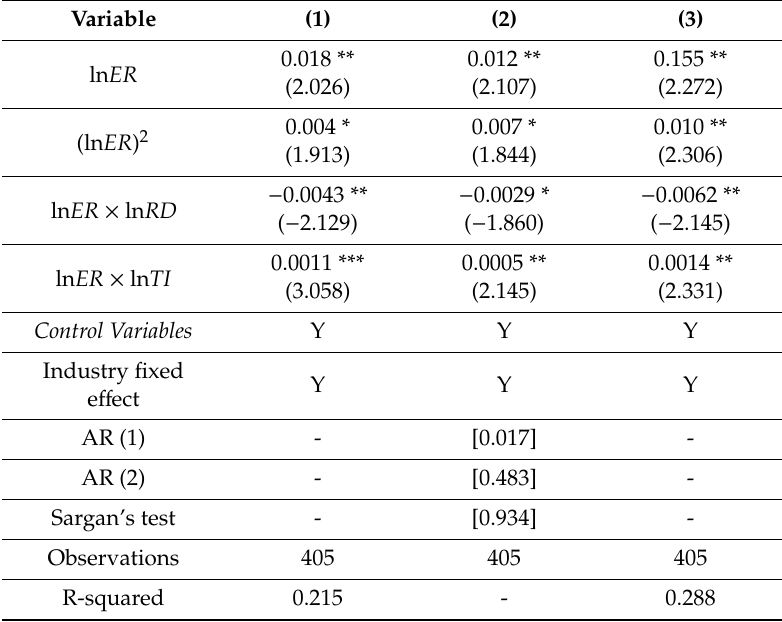
Table 5. Results of tests on influencing